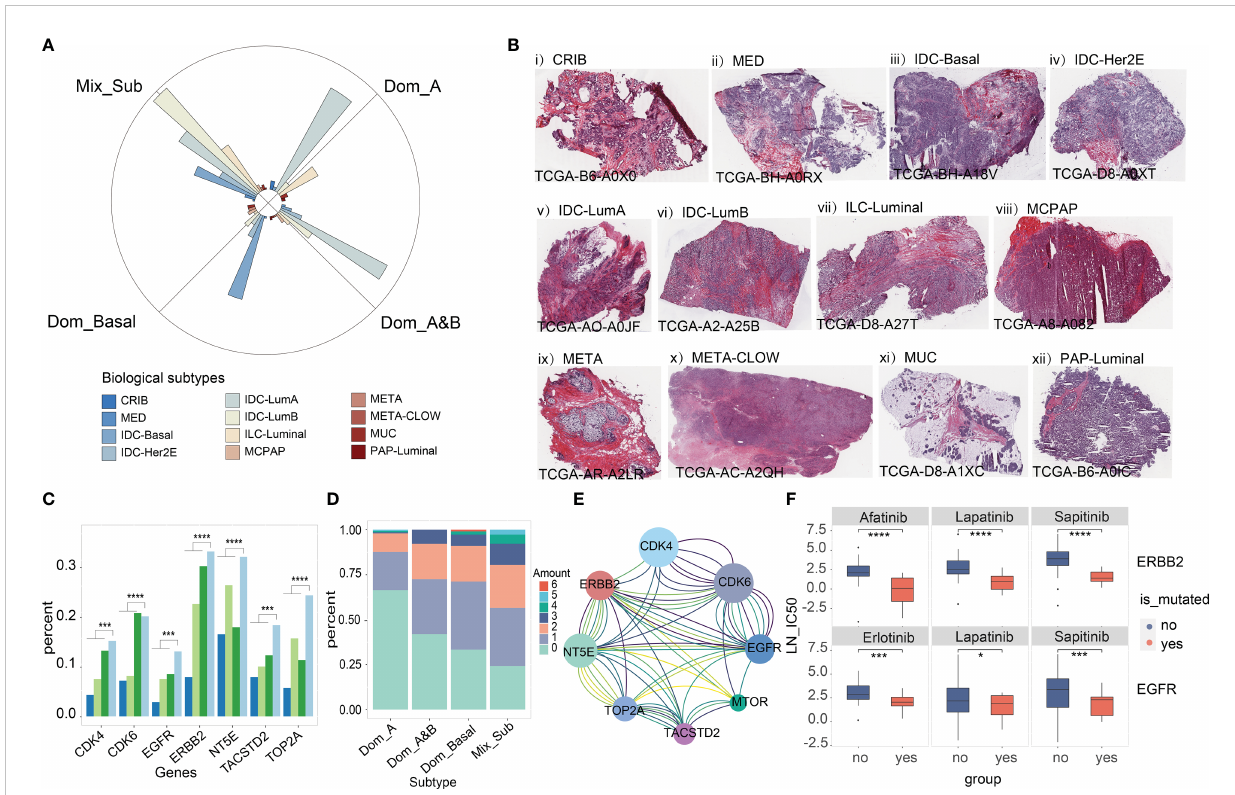
FIGURE 5 (A) Distribution of the 12 consensus groups previously reported for TCGA-BRCA in 4 subtypes. (B) Pathological sections of 12 consensus groups classi fi ed according to a combination of molecular and histological features. (C) Mutation load of seven targeted therapeutic genes associated with breast cancer treatment from the literature (Wilcoxon-test, '***'p < 0.005, '****'p < 0.001). (D) Common mutations in 7 target genes. (E) Lines of the same color connect genes that are simultaneously mutated only in patients with the Mix_Sub subtype. (F) Drug susceptibility prediction for gene mutation ( ‘ yes ’ is the mutant group, ‘ no ’ is the unmutated group). Student's t-test, '*'p < 0.05, '***'p < 0.005, '****'p <